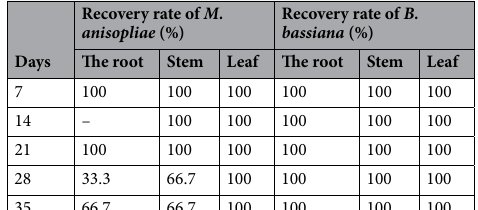
Recovery rate of B. bassiana